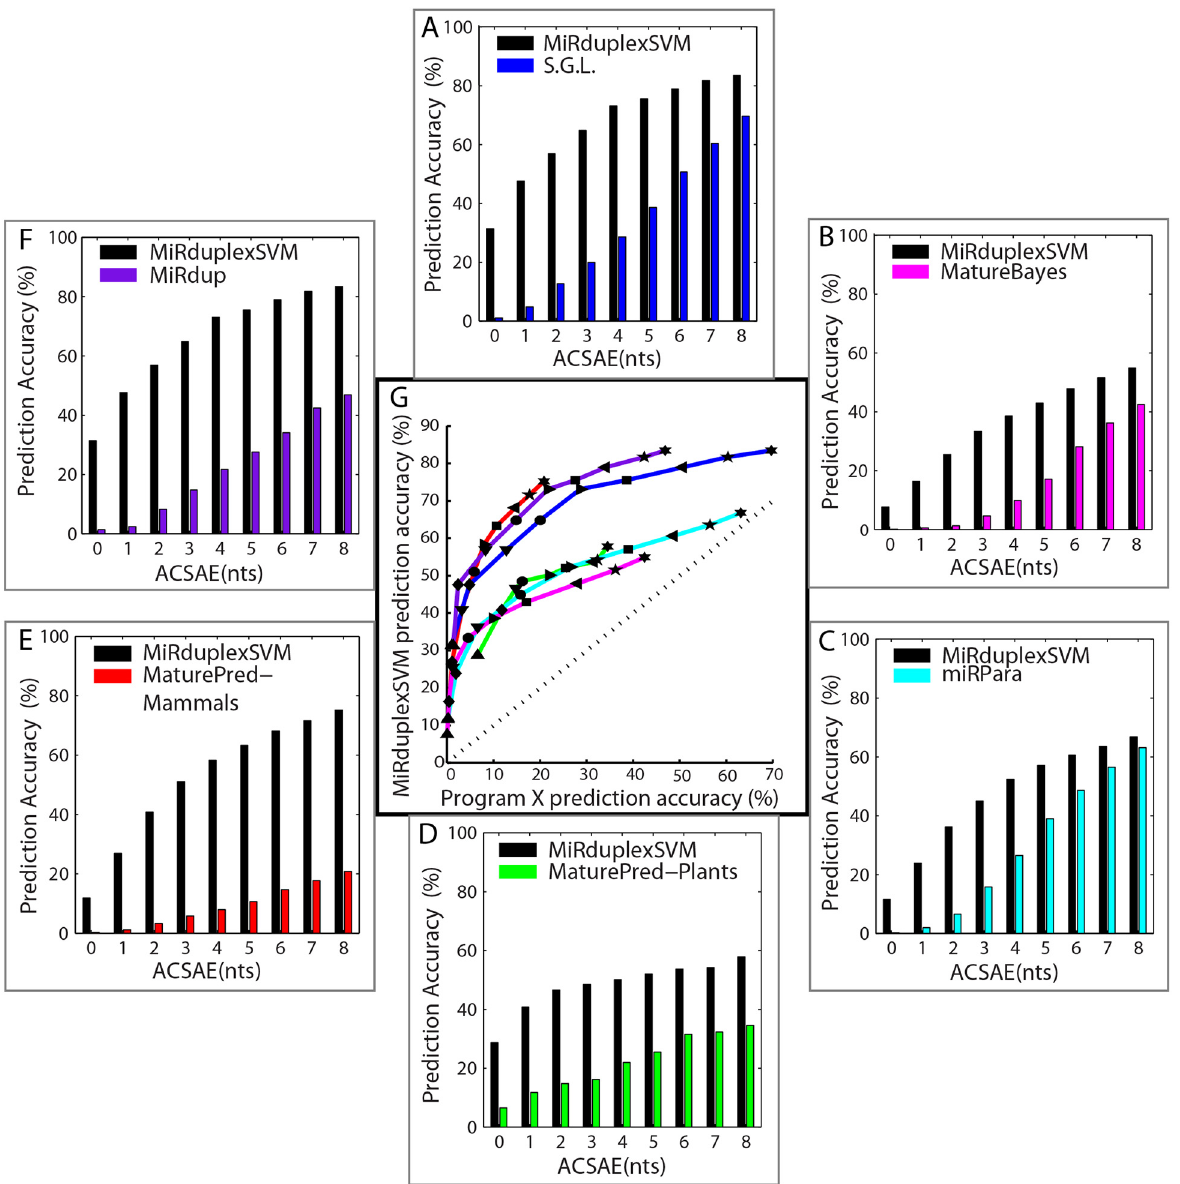
Fig 3. Prediction accuracy of MiRduplexSVM and six other methods on duplex identification. Panels A-F show the prediction accuracy (y-axis) of MiRduplexSVM (in black) and a second compared tool (in colour) as a function of the All Corners Sum Absolute Error (ACSAE, x axis) for errors of 0-8nts. The performance of the Simple Geometric Locator (S.G.L.), MatureBayes, miRPara, MaturePred-Plants, MaturePred-Mammals and MiRdup is shown in A — blue bars, B — pink bars, C — cyan bars, D — green bars, E-red bars and F-purple bars, respectively. Panel G shows the prediction accuracy of MiRduplexSVM (y axis) against the prediction accuracy of each compared tool (x axis). The colour code is the same as in A-F. Symbols (upward triangle, diamond, downward triangle, circle, right pointed triangle, square, left pointed triangle, pentagram star and hexagram star) correspond to errors less than or equal to 0, 1, 2, 3, 4, 5, 6, 7, 8 nucleotides, respectively. All points above the diagonal in G are statistically significant at level